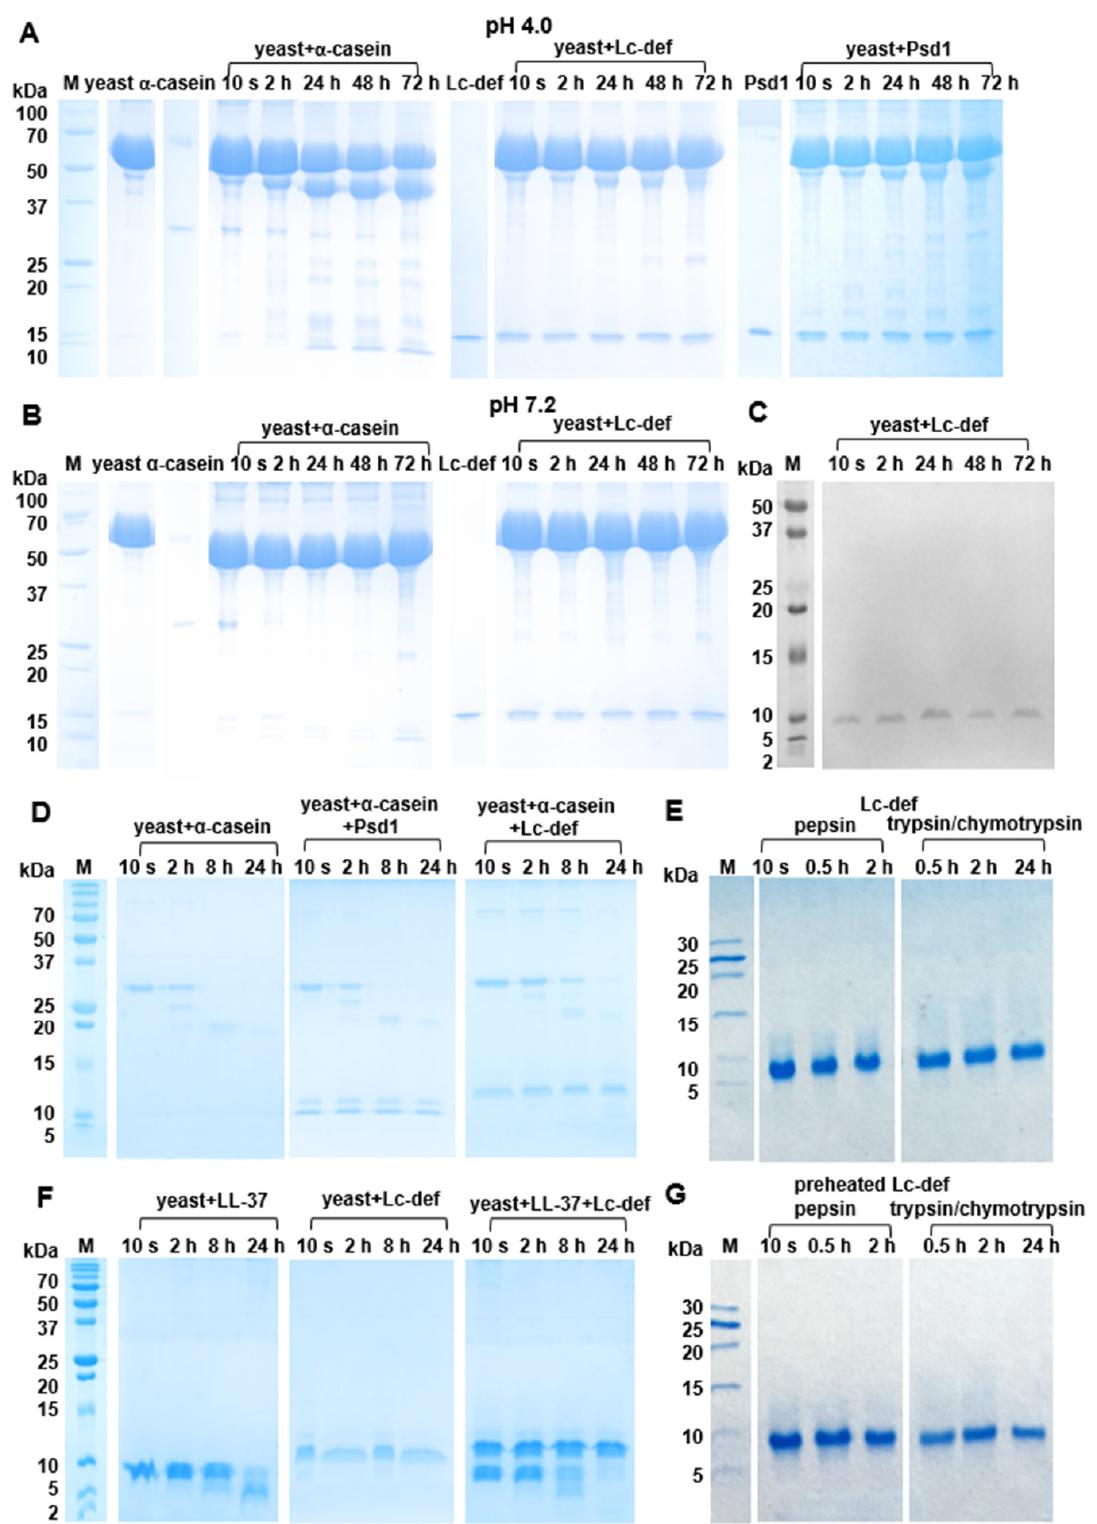
Figure 4. Resistance of Lc-def to proteolysis. ( A , B ) Results of α -casein, Lc-def, and Psd1 incubation with yeast (10 9 cell/mL) in buffer solutions (pH 4.0 or 7.2) during 10 s and 2, 24, 48, and 72 h as detected by SDS-PAGE (15%T, 3%C in the separating gel). ( C ) Immunoblotting of aliquots obtained after Lc-def incubation with yeast (10 9 cells/mL) in the buffer solution with pH 7.2 using polyclonal rabbit anti-Lc-def IgG. ( D , F ) Results of α -casein and LL-37 incubation with yeast (10 3 cells/mL) in